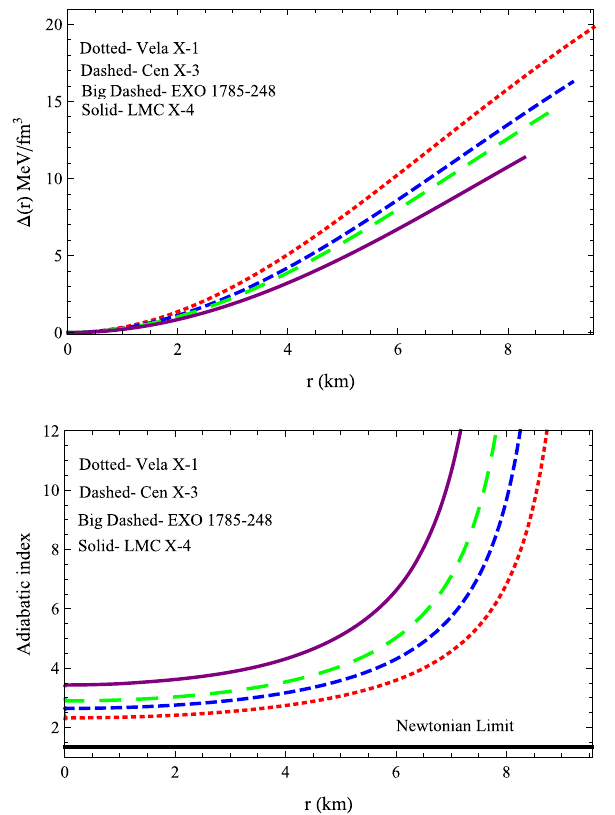
ond or both the factors on right-hand side of Eq. (10) are zero. The vanishing of first factor on the right side of Eq.